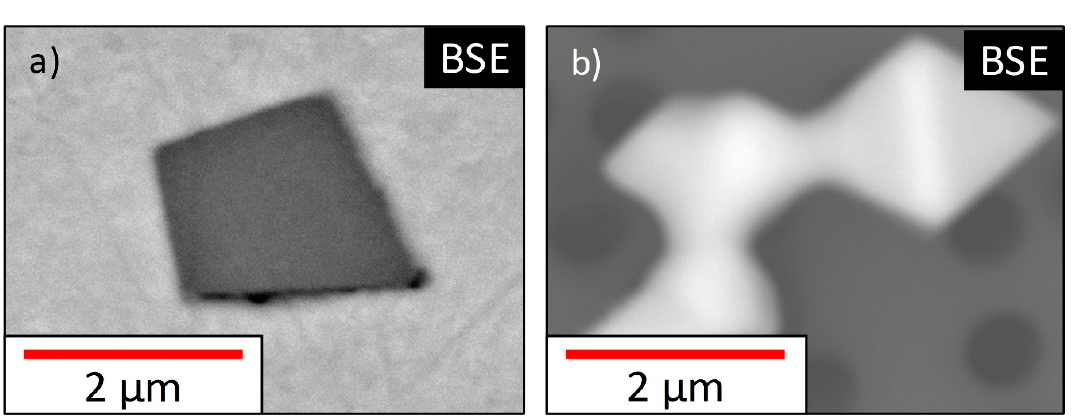
Figure 3. Particles of the same origin in different states: cross-section ( a ) and extracted form ( b ).